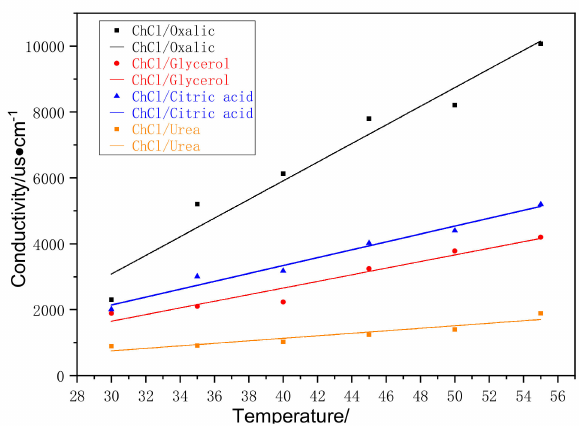
Figure 2. The e ff ect of temperature on the conductivity of